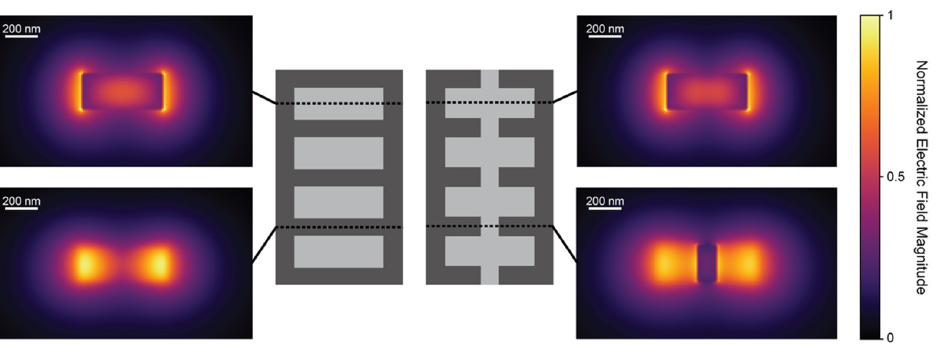
Figure 3. Simulated effective index, n eff , versus duty cycle, δ , for SWG waveguides with a grating period Λ = 250 nm, width w = 500 nm, thickness t = 220 nm, and fishbone width w fb = 0–220 nm, operating with ( a ) 1550 nm and ( b ) 1310 nm light. The shaded area represents the region where n eff is below the substrate leakage loss cutoff of 1.65, as reported by Sarmiento-Merenguel et al. [80]. Dashed regions of curves indicate waveguide geometries with feature sizes smaller than the 60 nm limit of the electron-beam lithography process used for silicon photonic (SiP) chip fabrication in this work. Simulated bulk sensitivity, S b , versus δ for SWG waveguides with Λ = 250 nm, w = 500 nm, t = 220 nm, and w fb = 0–220 nm, operating with ( c ) 1550 nm and ( d ) 1310 nm light. Simulations were performed using a 3D-FDTD approach with water as the cladding.